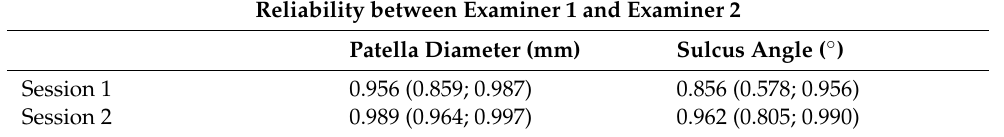
Table 4. Reliability between patella diameter and sulcus angle measurements carried out by experi- enced and inexperienced